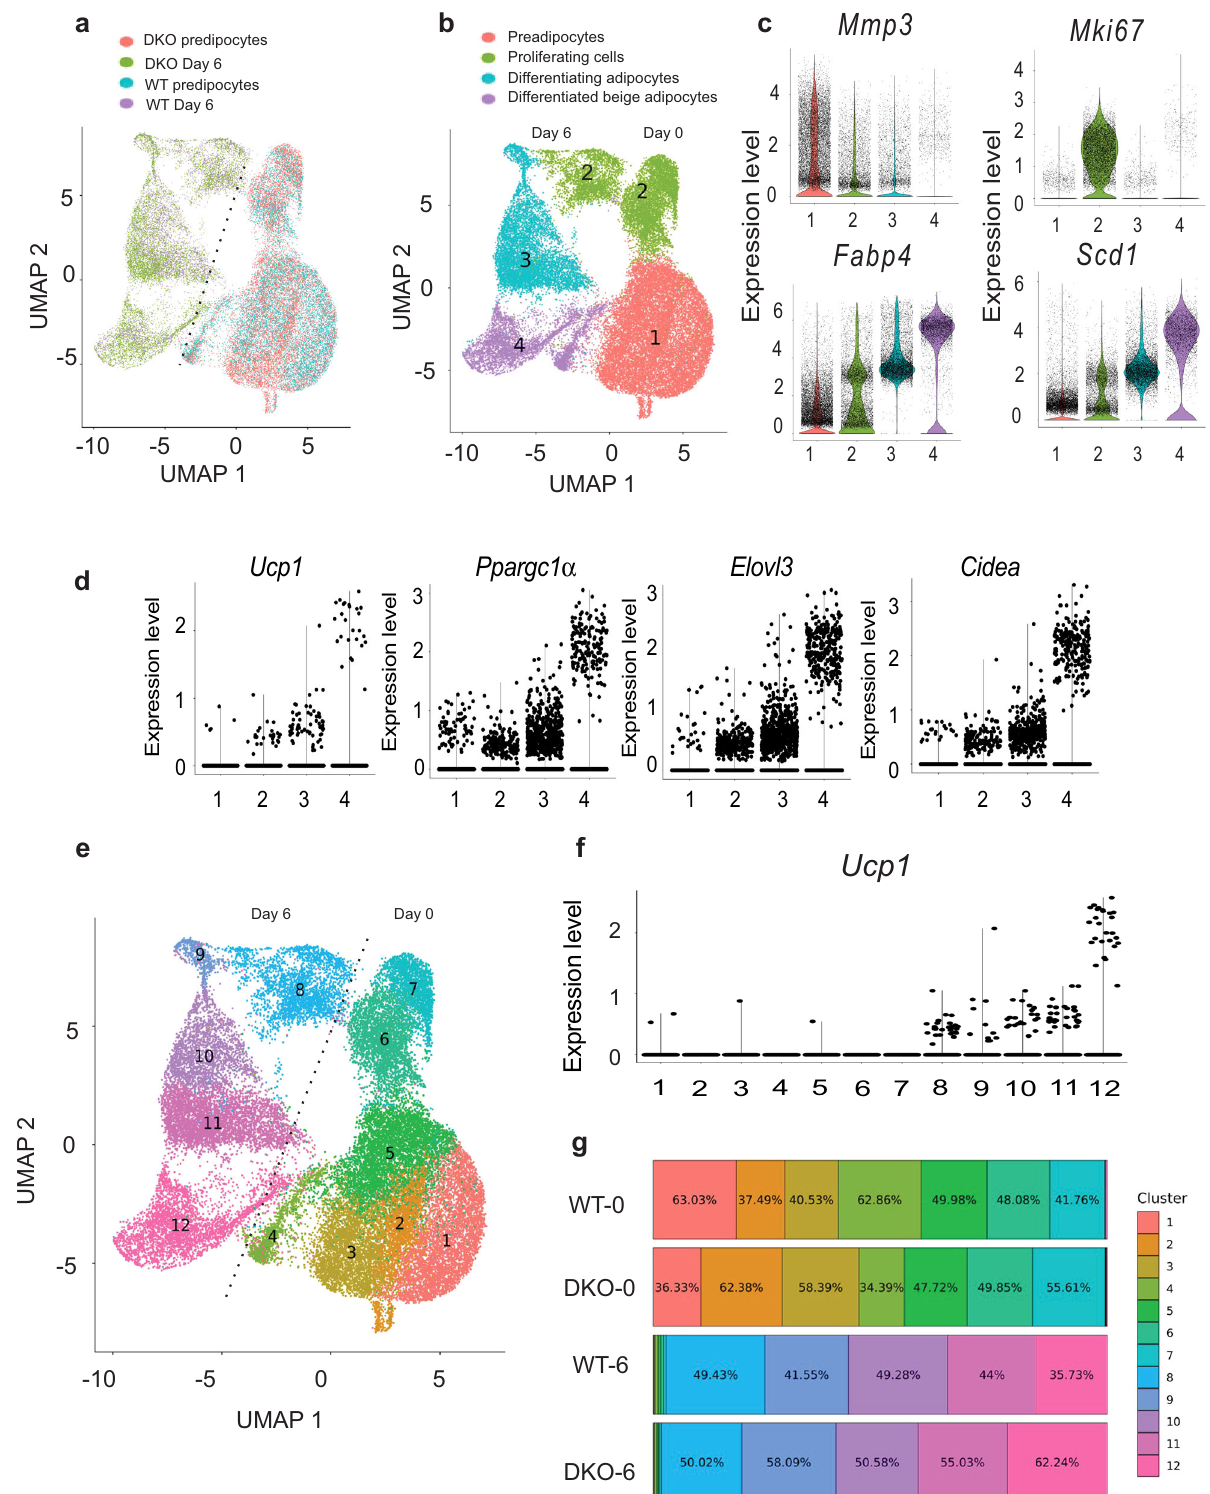
Fig. 4 | Single-cell RNA seq analysis during white preadipocyte browning. a UMAP plot identifying the population of WT or DKO preadipocytes in the sepa- ratedcellclustersatdays0and6ofinducedbrowning.Duplicatesamplesofwhite preadipocytes derived from either WT or DKO mice were induced to differentiate. Sampleswerecollectedatday0andday6andanalyzedbyscRNAseq.Shownisan aggregate plot of all samples. b UMAP plots showing various annotated clusters of aggregate scRNAseq analysis at days 0 and 6 during the browning of white